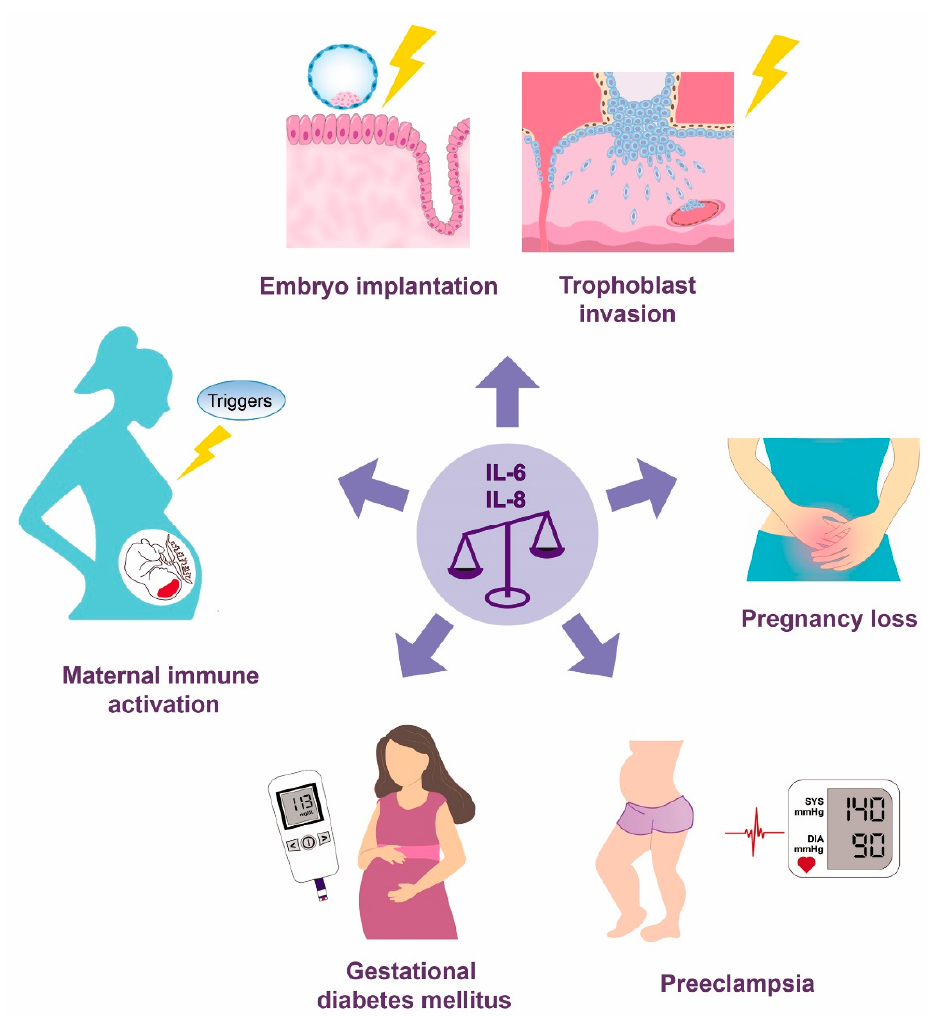
Figure 1. Implication of the IL-6 and IL-8 disbalance in the embryo implantation and trophoblast invasion, and the pathological pregnancy conditions – pregnancy loss, preeclampsia, gestational diabetes mellitus and maternal immune activation, based on the literature data.